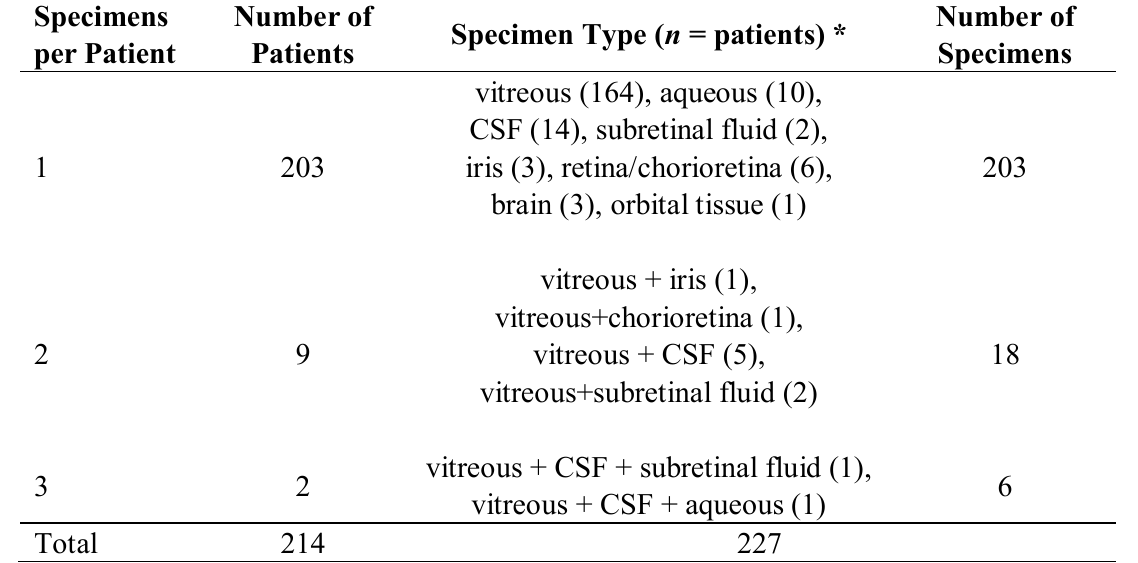
Table 1. Specimen submission in patients with masquerade syndrome.